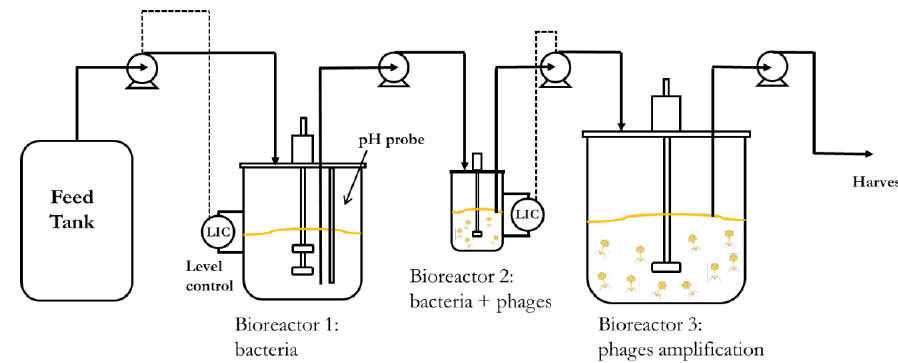
Figure 1. Schematic showing layout of the continuous phage production process, which was a three-stage continuous stirred tank system with bioreactors connected in series: the first reactor (Bioreactor 1, R1) had a fixed working volume of 500 mL, the second reactor (Bioreactor 2, R2) had variable working volumes ranging from 33 mL to 100 mL, thereby permitting different dilution rates (D 2 ) for phage production using the same flow rate through the process, and the third reactor (Bioreactor 3, R3) was operated as a semi-batch reactor. Host E. coli were propagated in R1; the working volume was controlled using a level control system. The T3 infection of bacteria occurred in R2, which was fed with host bacteria continuously from R1. R2 was operated below the dilution rate where phage washout would occur; hence, steady-state operation allowed the phage population to be continuously maintained in R2. Phage-infected cells and free-floating phage were continuously withdrawn from R2 to R3 (flow rate synchronized with R1 using a level control system on R2) where multiple cycles of infection resulted in further phage amplification and completion of the phage production process.